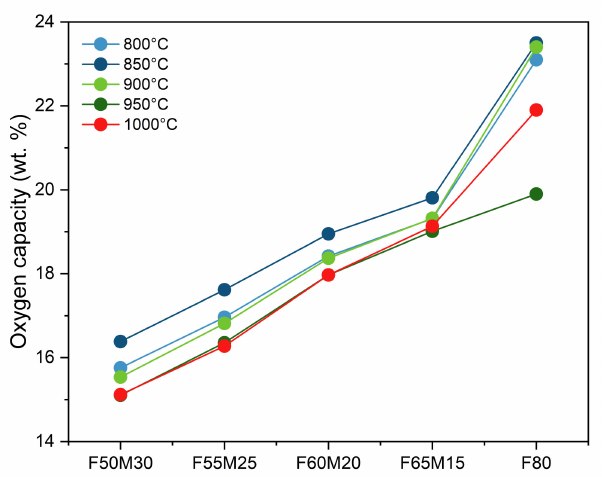
Figure 5. Oxygen transport capacity as a function of temperature and chemical composition for Fe- Mn/Zr oxides